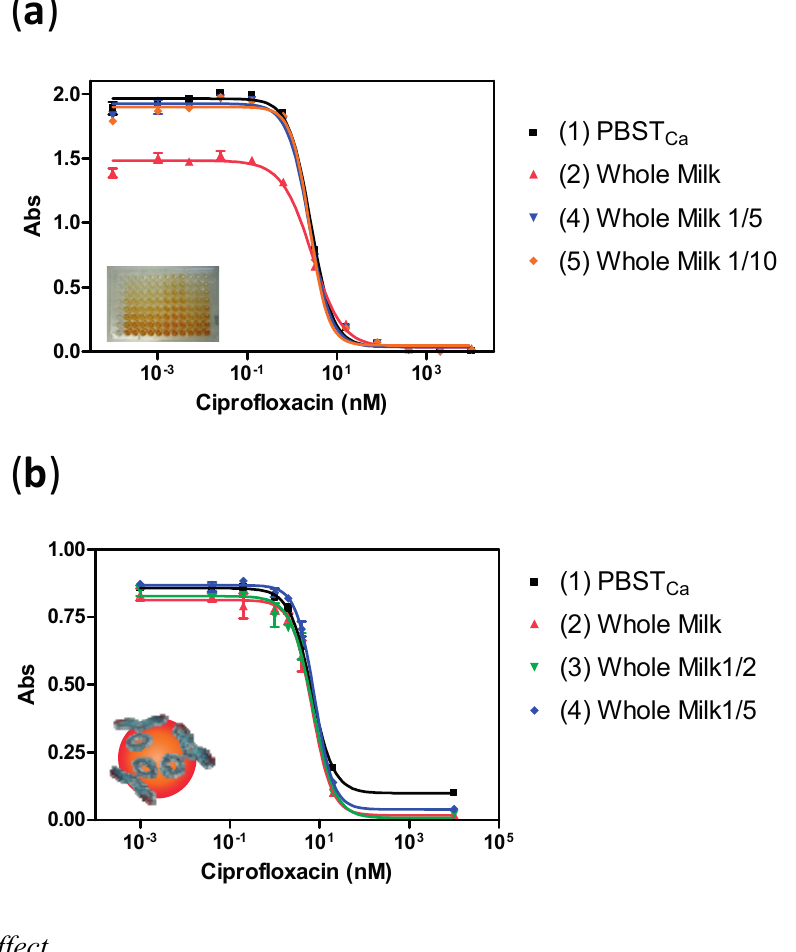
Figure 4. Milk matrix effect using ( a ) ELISA and ( b ) m-ELISA for the TE built in (1) PBST buffer, (2) Whole milk, (3) Whole milk diluted two times in PBST Ca buffer, (4) Whole milk diluted five times in PBST times in PBST buffer. Each point was the average of at least three-well replicates, and the Ca assays were run on two different